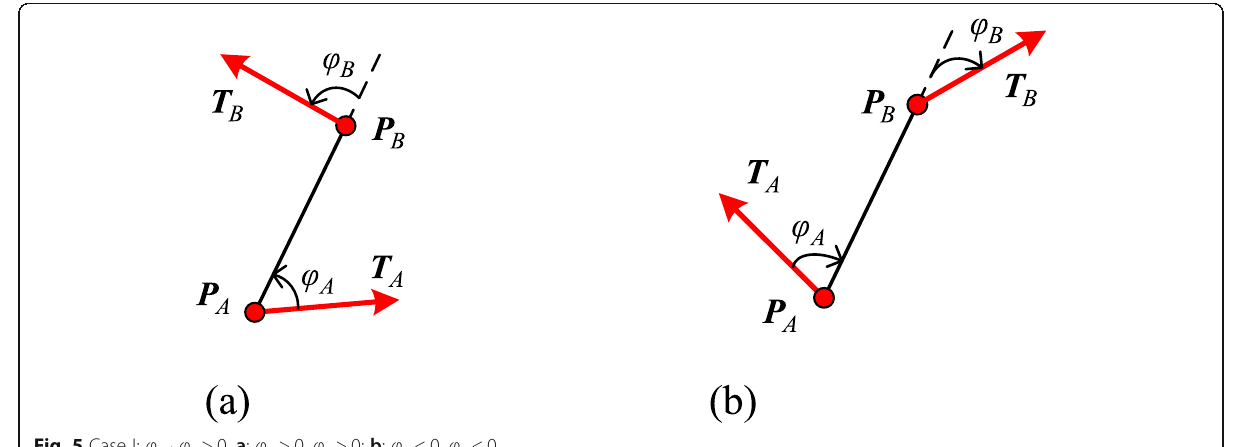
Fig. 5 Case I: φ A ⋅ φ B > 0. a : φ A > 0, φ B > 0; b : φ A < 0, φ B <